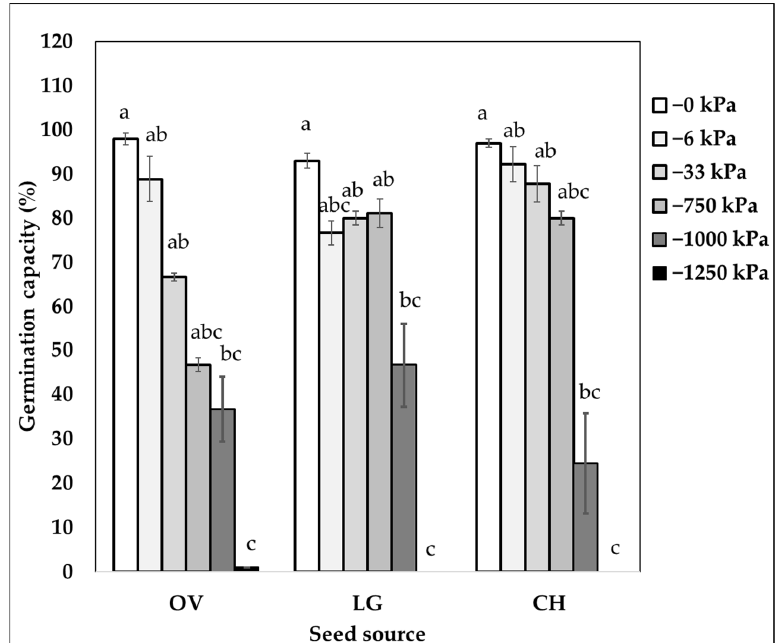
Figure 1. Percentage of germination capacity of P. chilensis by seed source and by matric potential (log-kPa). North-south order: OV = Ovalle; LG = Chalinga and CH = Chacabuco. Lowercase letters show a significant difference between matric potential for each seed source according to the non-parametric Kruskal Wallis test ( p < 0.05).